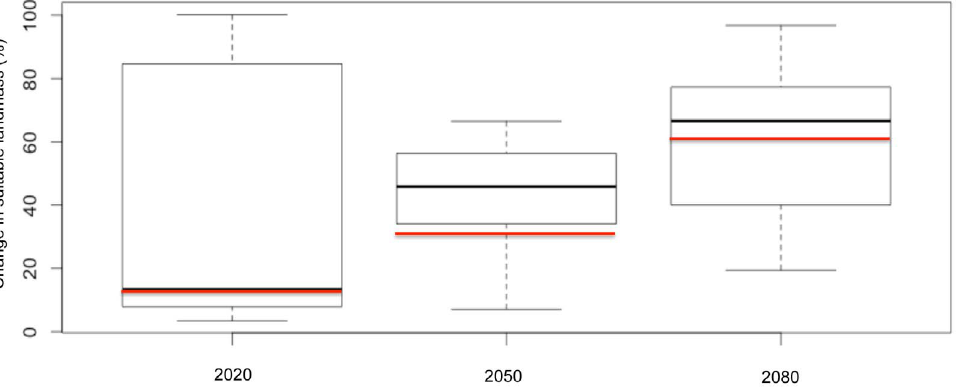
Figure 3. Change in suitable landmass over time relative to the currently suitable landmass. The boxplot represents variation of projections across six future climatic scenarios, each based on a different combination of Global Climate Model 6 CO 2 emission scenario, per time horizon ( 6 s.d). The red line indicates the value of the consensus model.